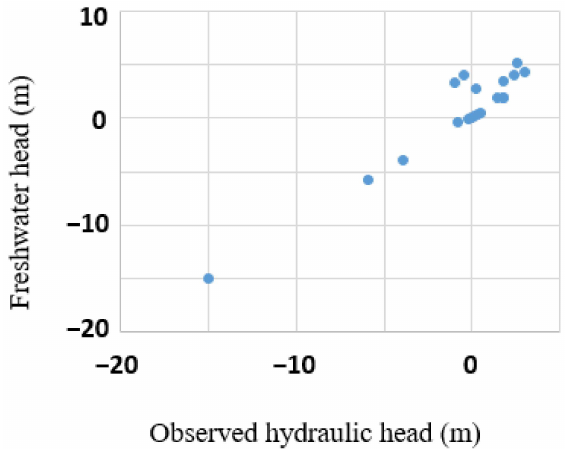
Figure 5. Freshwater heads and observed hydraulic heads for saline groundwaters during 2012.